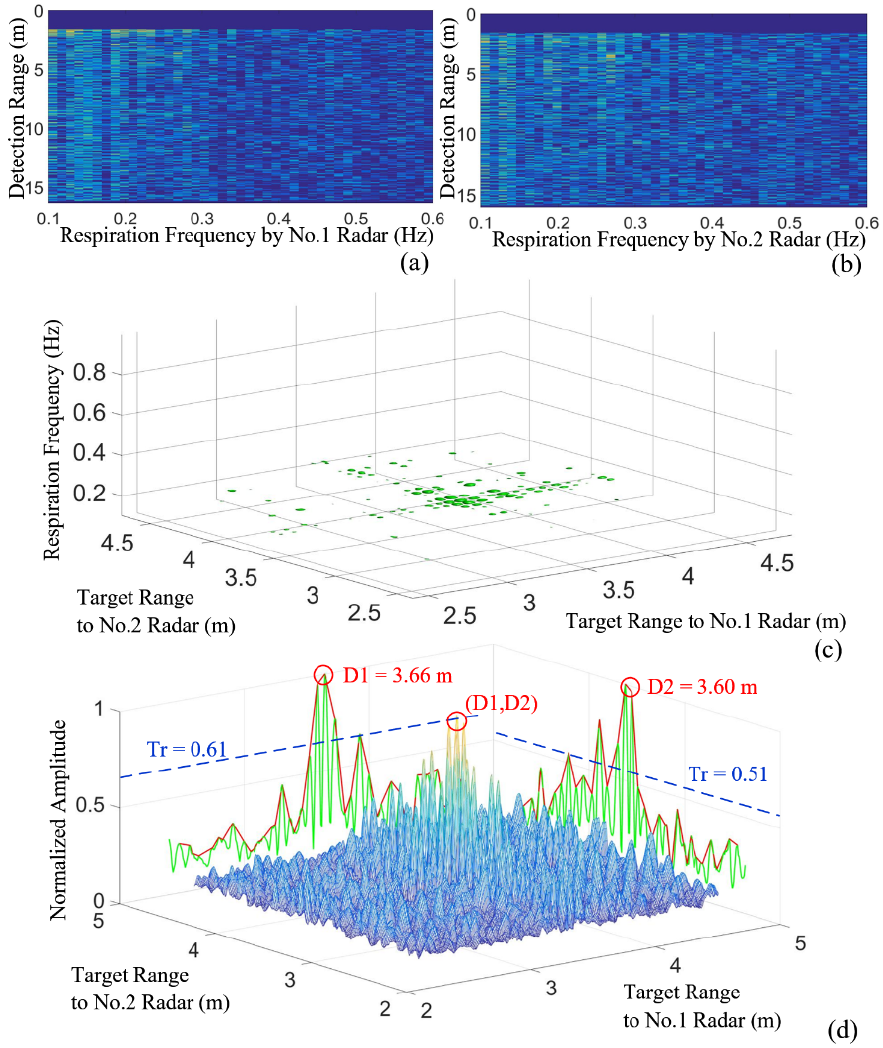
Figure 17. Measurement results for ruins scene. ( a , b ) The output range-frequency images using the normal FFT-based respiration detection methods using the echoes from a single radar. ( c ) The output cross-correlated range-frequency three-dimensional (3D) image, with the vital sign feature (VSF) marked in green. ( d ) The output two-dimensional (2D) slice (range × range) image for the specific respiration frequency.